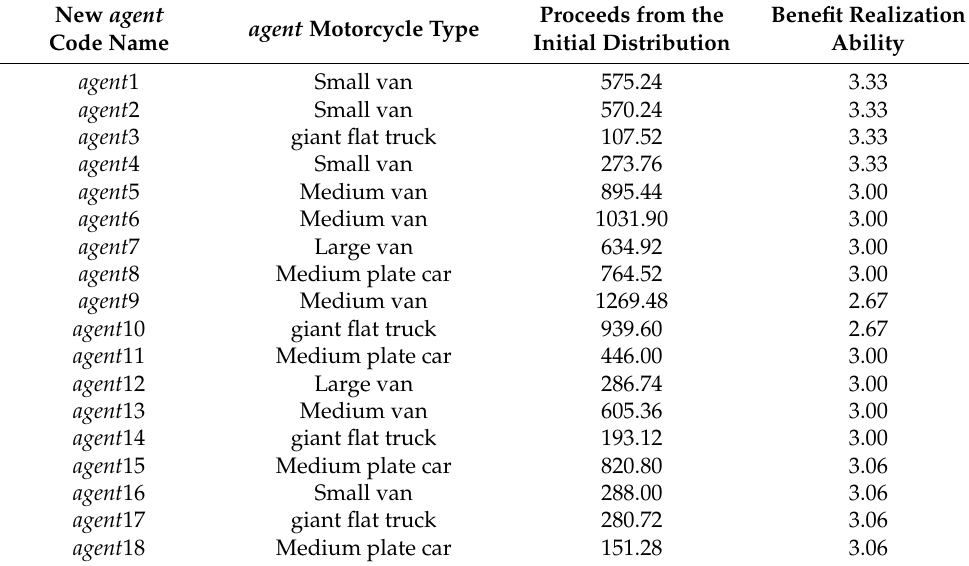
Table 2. Initial agent revenue and vehicle model